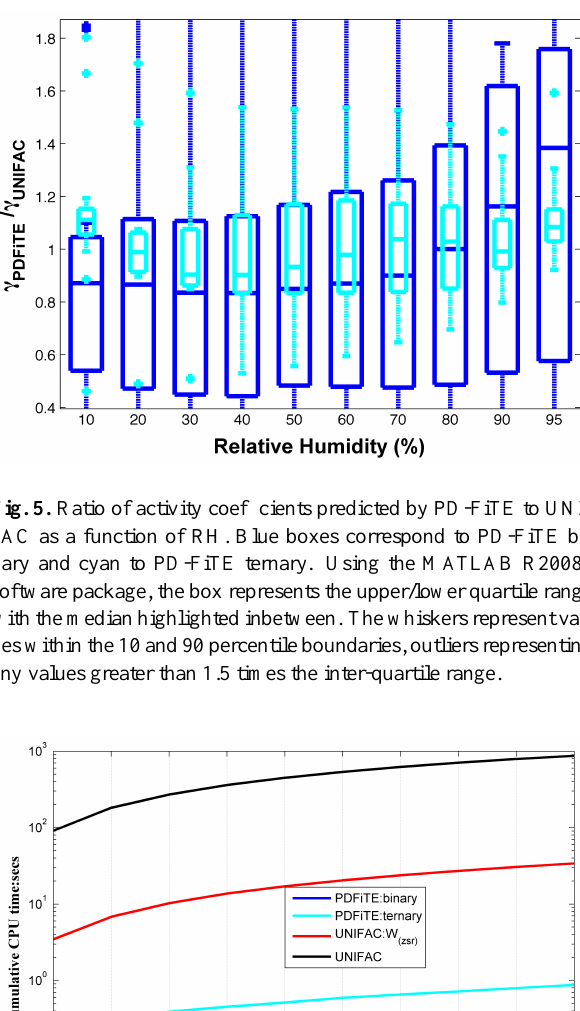
Table 4. Average percentage deviations between PD-FiTE and UNIFAC. Statistics averaged across 100 random initializations at